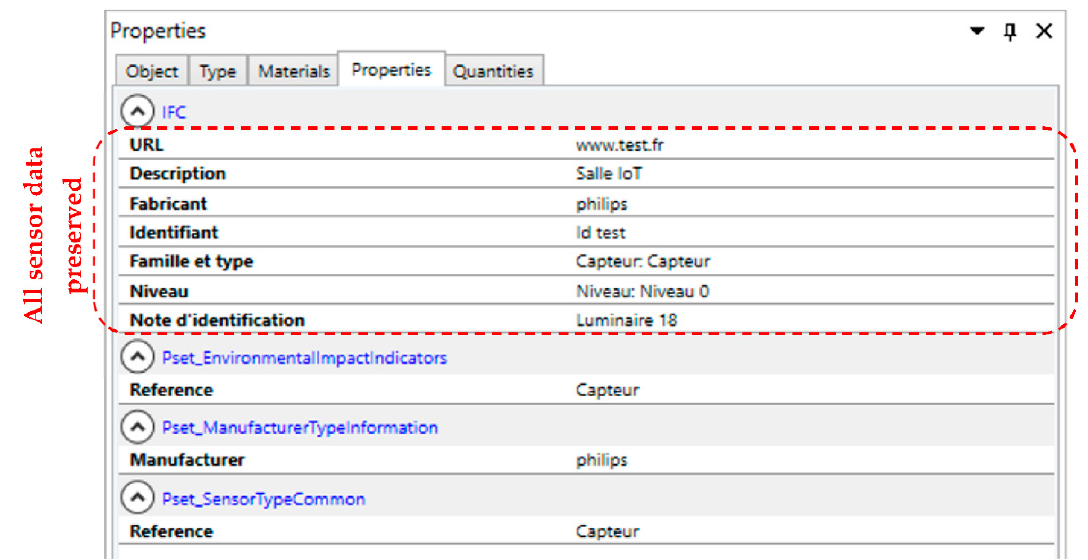
Figure 7. View of exported semantic data to XbimXplorer in IfcSensor using property